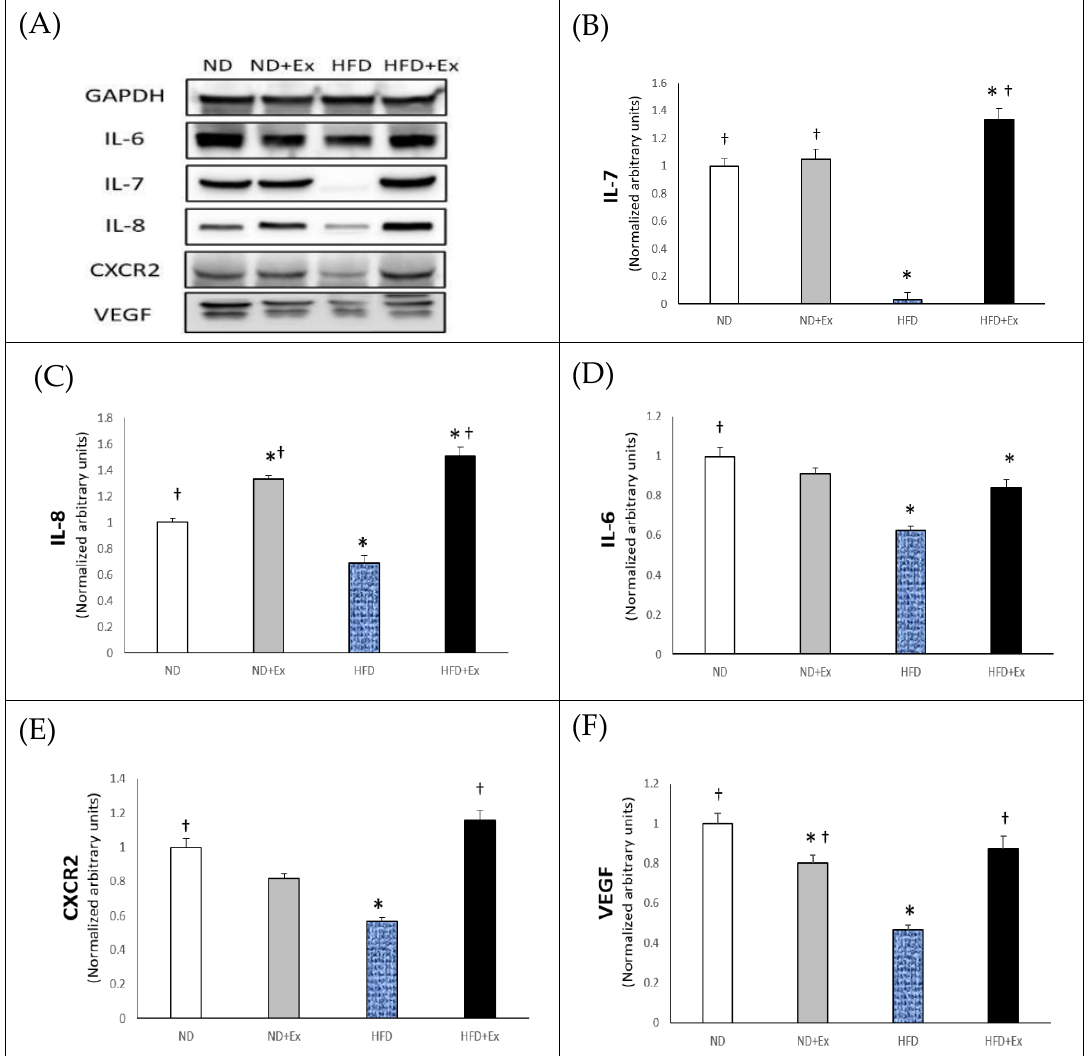
Figure 3. Comparison of myokines protein expression in the normal diet, normal diet + exercise, high fat diet, and high fat diet + exercise groups. ( A ) Myokines levels in skeletal muscle lysates were analyzed by western blot. ( B – F ) IL-7, IL-8, IL-6, CXCR2, and VEGF levels. Results represent the mean ± SE. *, p < 0.05 vs. the ND group by one-way ANOVA; † , p < 0.05 vs. the HFD group by one-way ANOVA. ND, normal diet; ND+Ex, normal diet + exercise; HFD, high fat diet; HFD+Ex, high fat diet + exercise.